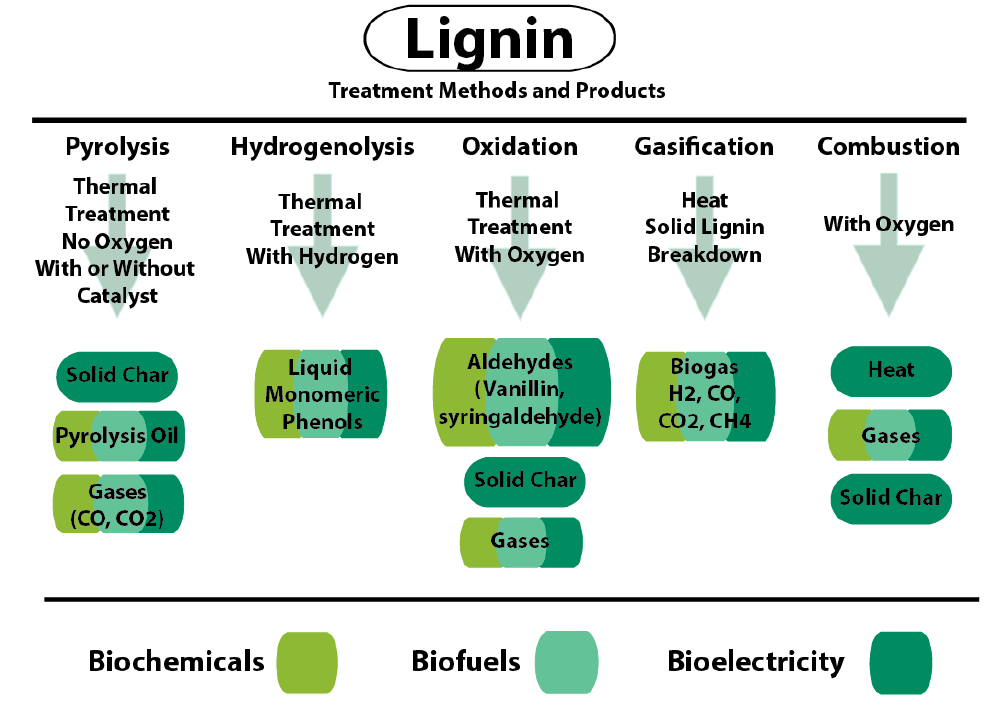
Figure 3. Chemical methods of lignin depolymerization and its end use in the production of chemicals, fuel and electricity. Lignin breakdown is carried out at high temperatures with or without added oxygen and hydrogen, depending upon the method. This results in varied levels of chemicals, liquid fuel and electricity produced. The color coding indicates the product type produced from the biomass